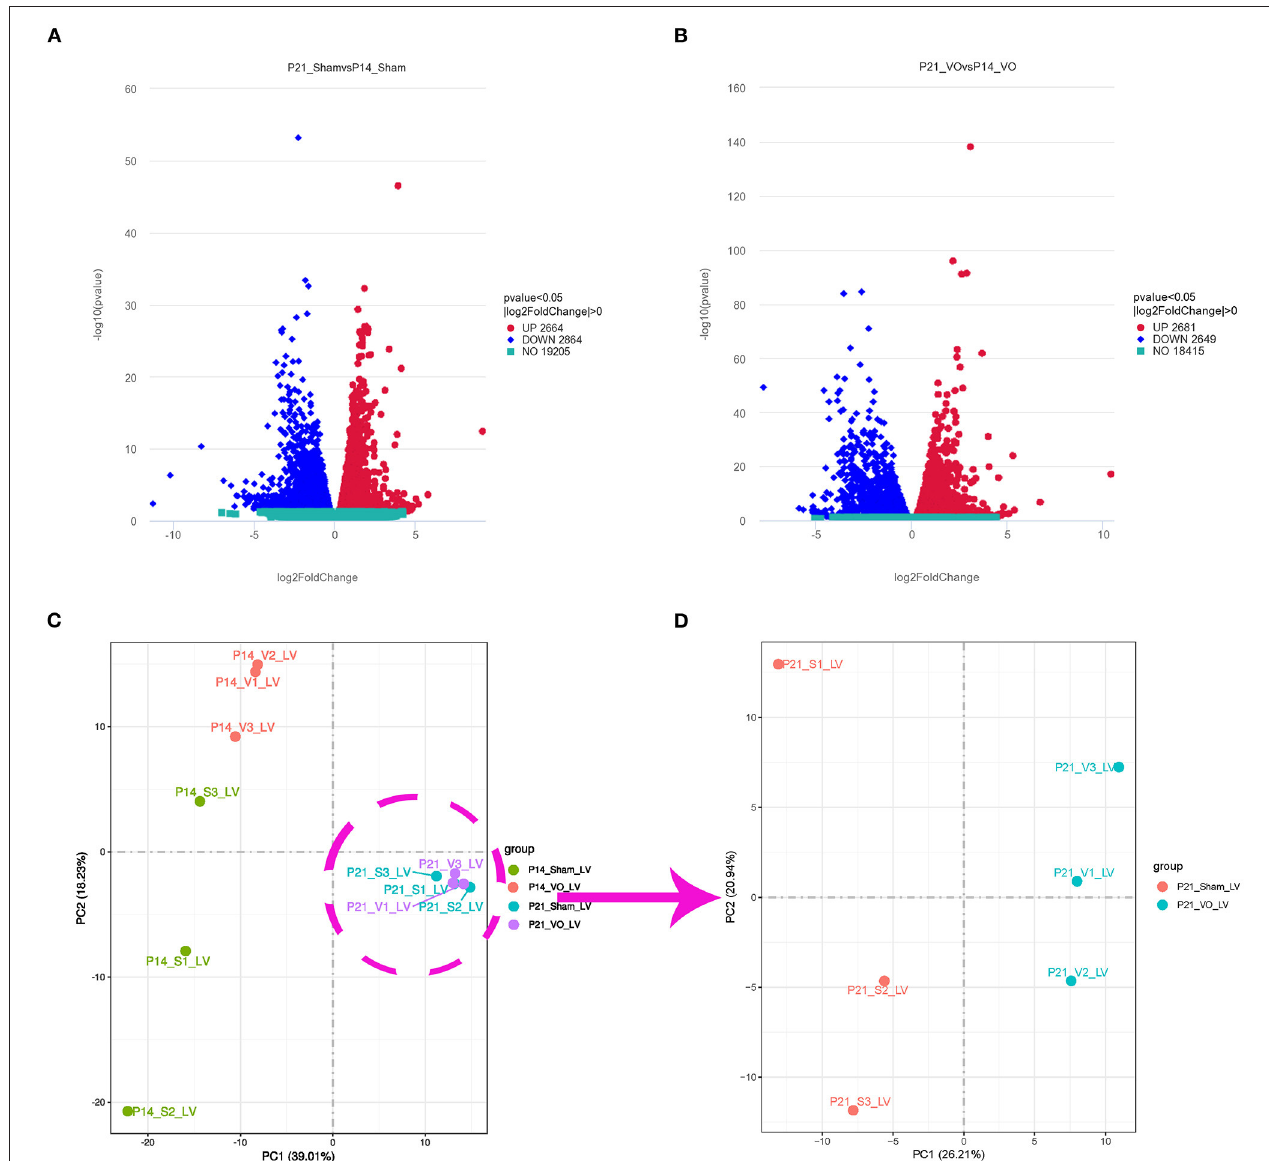
FIGURE 3 | Transcriptomic changes in postnatal left ventricular (LV) development. (A) Volcano map of differentially expressed genes (DEGs) of postnatal LV development in the normal condition (P21_Sham vs. P14_Sham). (B) Volcano map of DEGs of postnatal LV development under the influence of volume overload (VO) (P21_VO and P14_VO). (C) The principal component analysis (PCA) of DEGs of the VO and Sham groups at P14 and P21. (D) The PCA of DEGs of the VO and Sham groups at